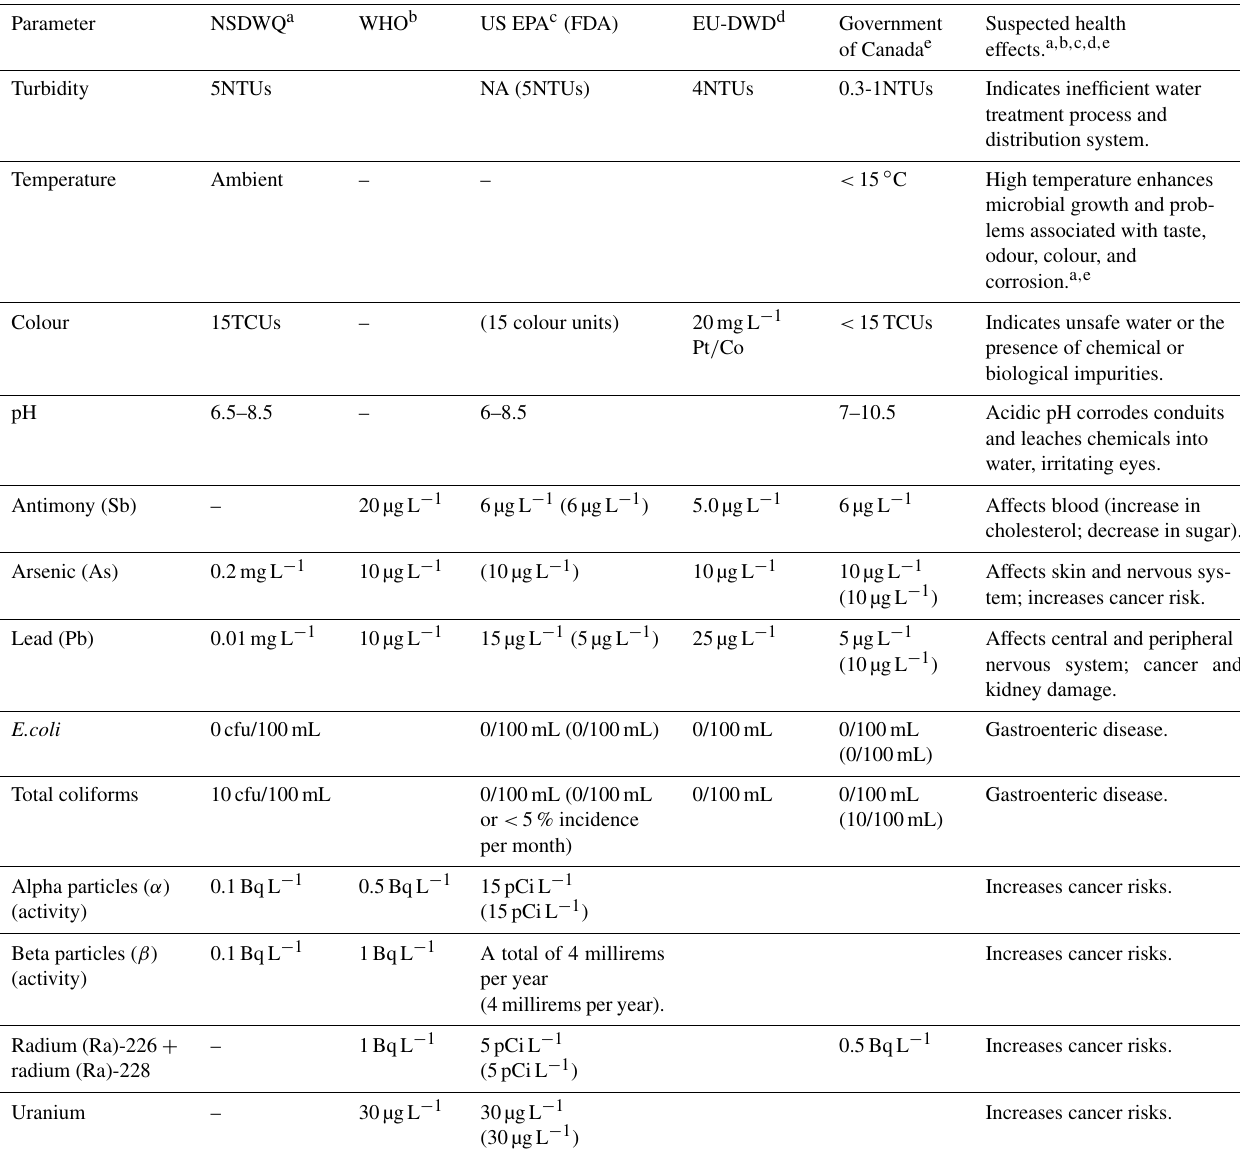
Table 1. Regulated standards of selected physical, chemical, biological, and radiological